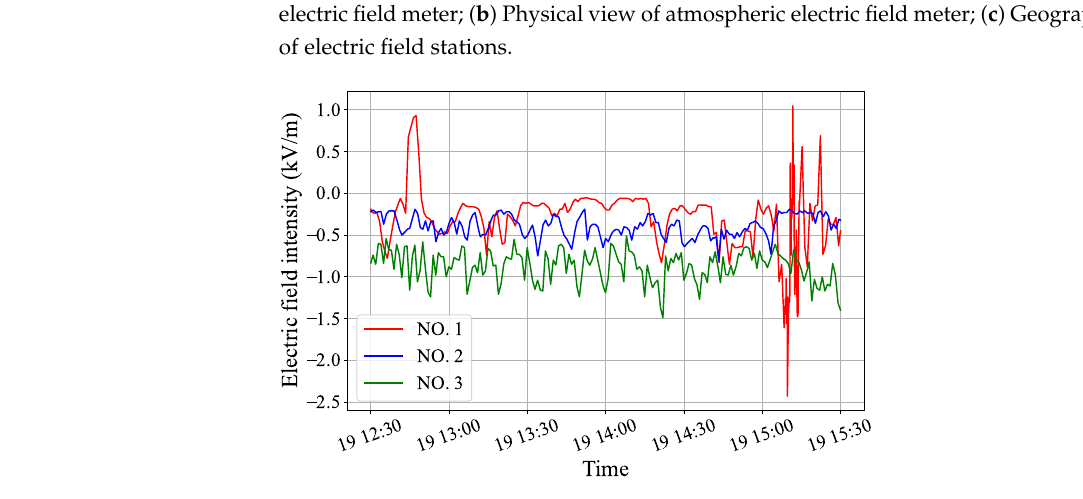
Figure 2. Changes in electric field measurements at No. 1, No. 2, and No. 3 stations (19 August 2021, 12:30–15:30